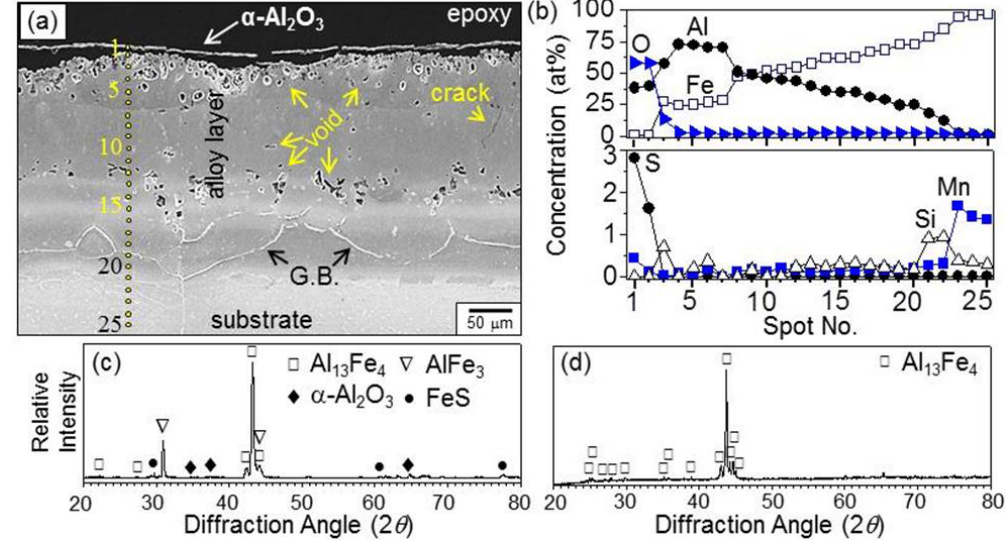
Figure 4. Al-hot dipped steel after corrosion in N 2 /0.1% H 2 S at 800 °C for 100 h: ( a ) etched cross-sectional SEM image; ( b ) concentration profiles of Al, Fe, Mn, Si, S and O; ( c ) XRD pattern taken from the air-side; ( d ) XRD pattern after grinding off the upper part of the coating.